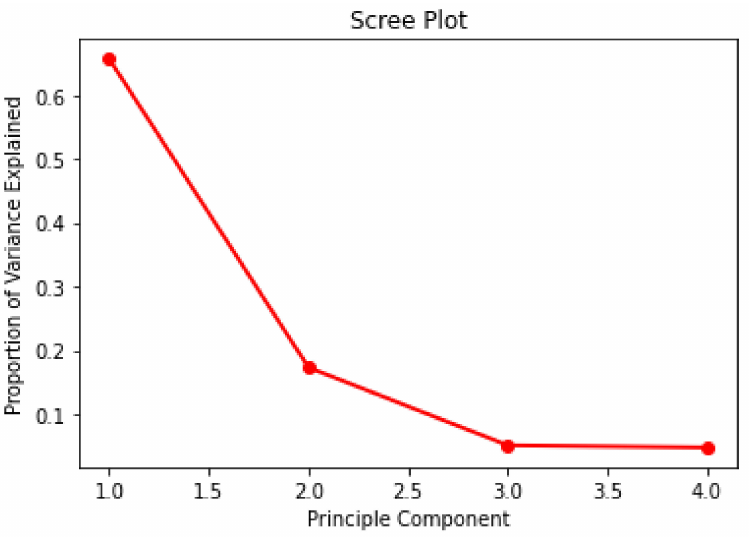
Figure 5. Scree Plot for